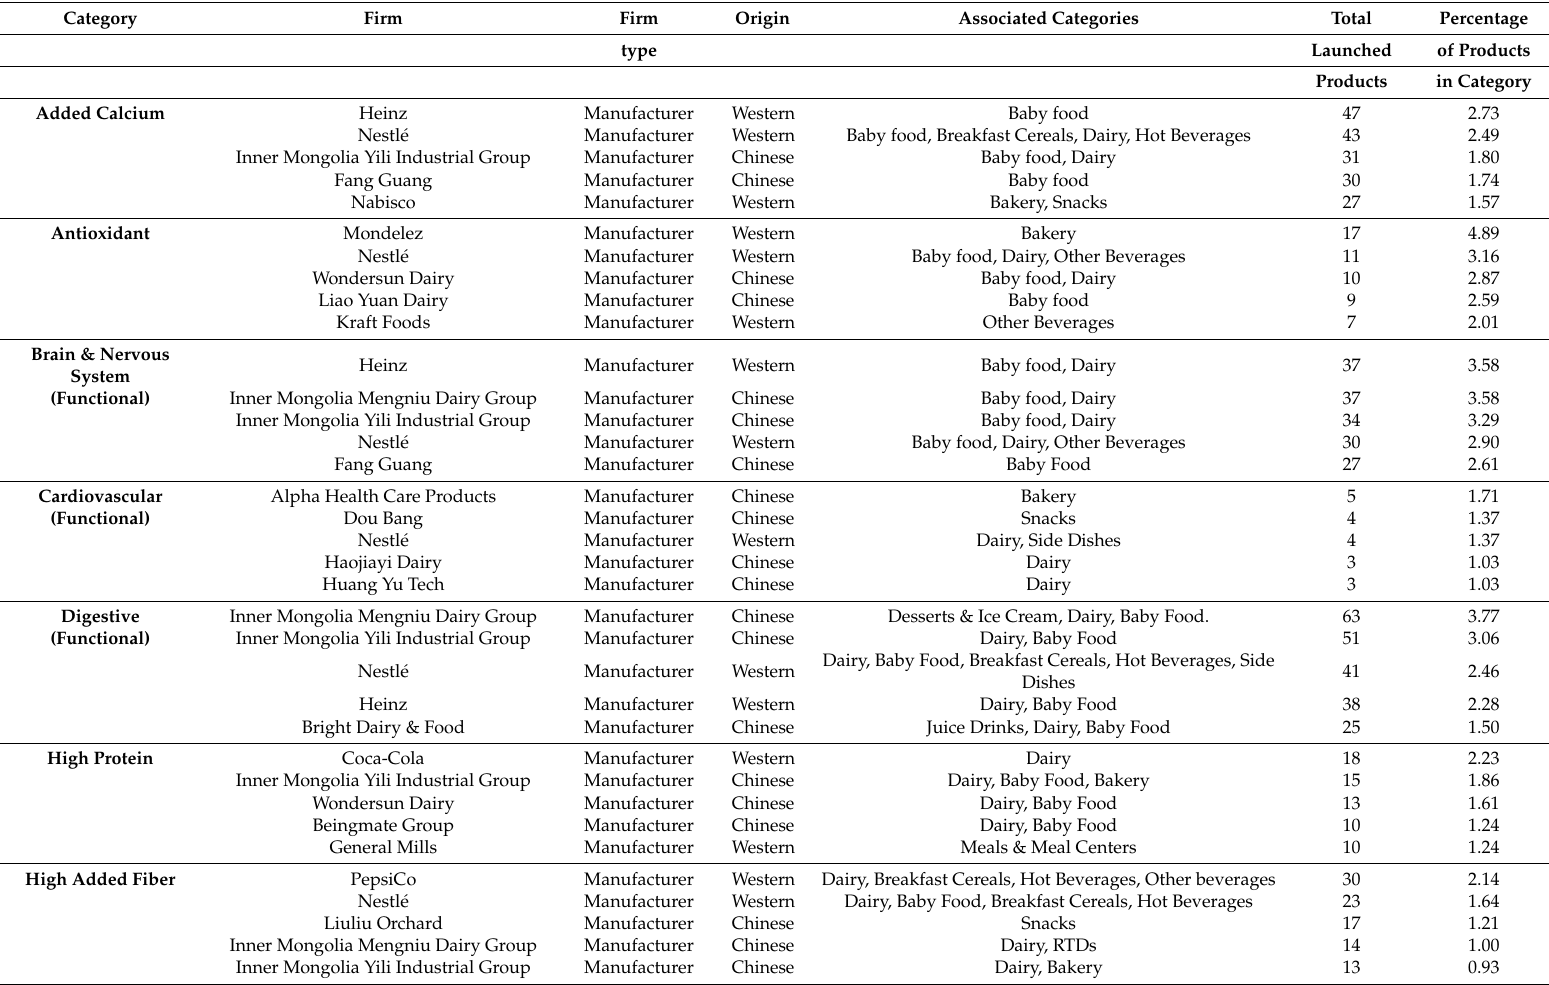
Table 4. Top 5 companies introducing products with safety, health and nutrition claims during the period